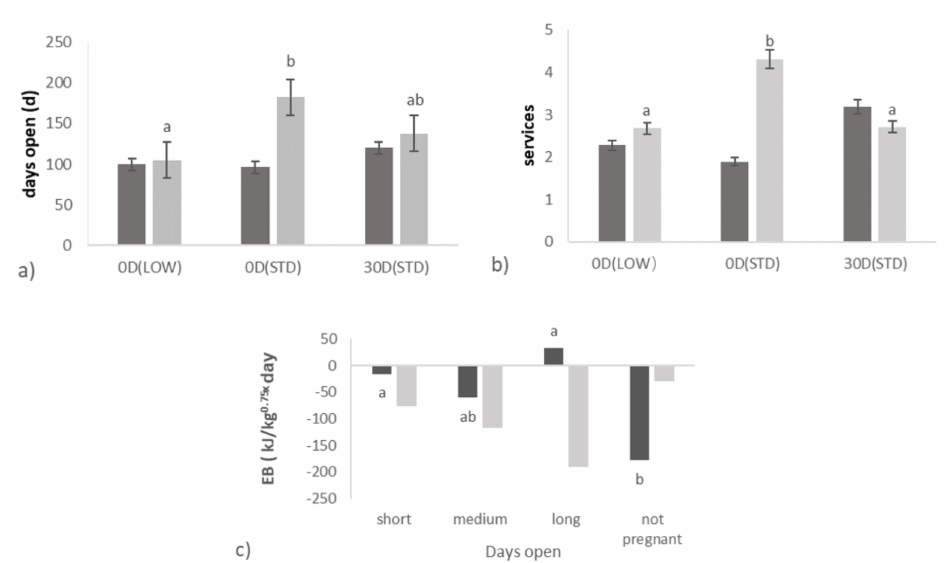
Figure 2. The e ff ect of transition treatments (0-d DP (LOW), 0-d DP (STD), 30-d DP (STD) for cows of di ff erent parity classes (parity = 2 in dark grey or parity ≥ 3 in light grey) on days open ( a ), services per pregnancy ( b ); The relation of days open class (short: < 80 d, medium: 80–130 d, long: > 130 d and not pregnant) for cows of di ff erent parity classes (parity = 2 in dark grey or parity ≥ 3 in light grey) with energy balance (EB) in week 1 till 7 of lactation ( c ); a,b Values within parity class in the same row with di ff erent superscripts di ff er ( p <